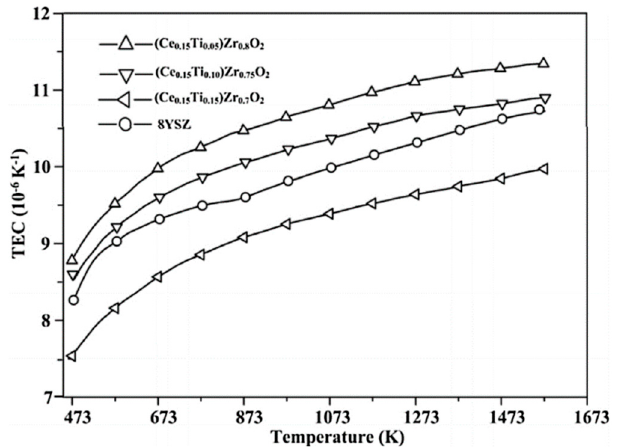
Figure 5. The thermal expansion coefficient of ZrO 2 -CeO 2 -TiO 2 and 8YSZ within a temperature range from 473 to 1573 K [50].